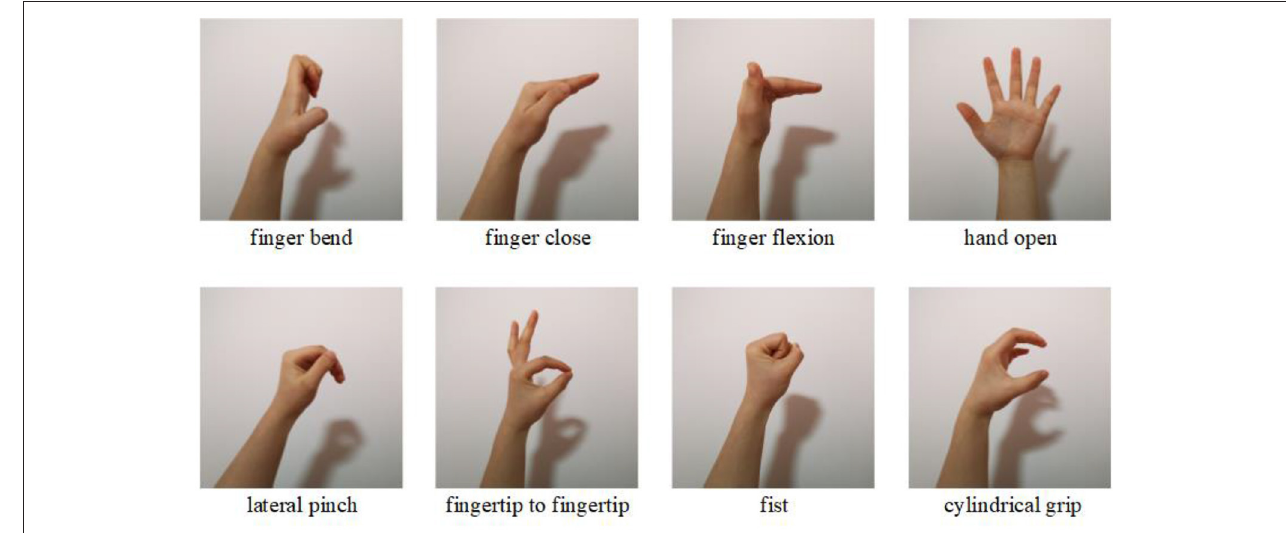
FIGURE 1 | The eight different hand patterns tested in the